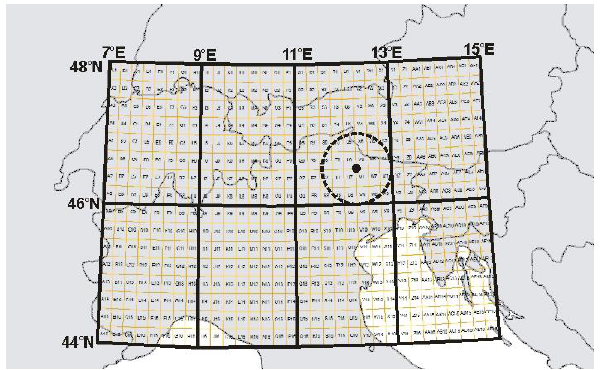
Figure 3. Debris flow basin reference point in context of meso-scale analysis domains. The bounding rectangle represents the meso- α scale and the circle (with 50km radius) represents the meso- β scale analysis unit. This meso- α scale also provides the spatial extent of the cloud-to-ground lightning data set used in the study. The labels in each grid are simple identifiers used in the mapping process, they do not represent any surficial or atmospheric